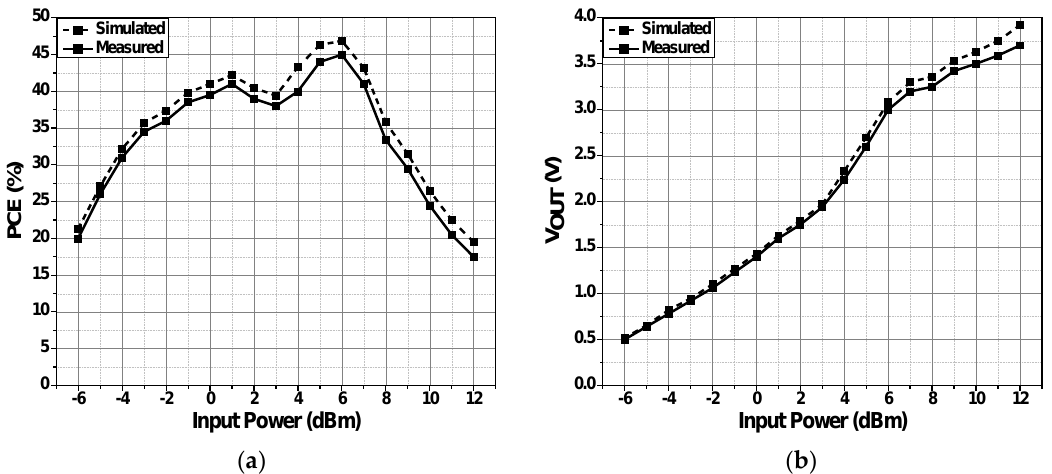
Figure 12. Measured results of the proposed circuit for 5 kΩ load. ( a ) PCE; and ( b ) output DC voltage.